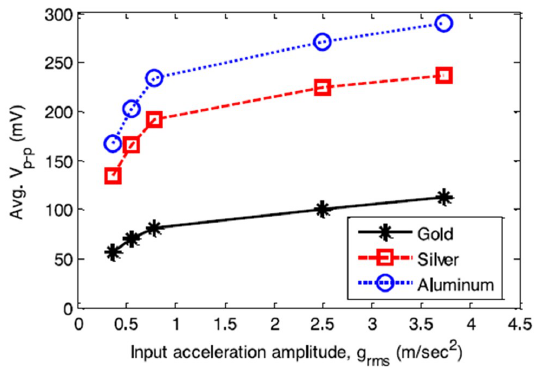
Figure 17. Average peak to peak open circuit voltage output for 400, 800, and 1200 mm 2 gold, silver, and aluminum electrode‐coated EAPap [81].